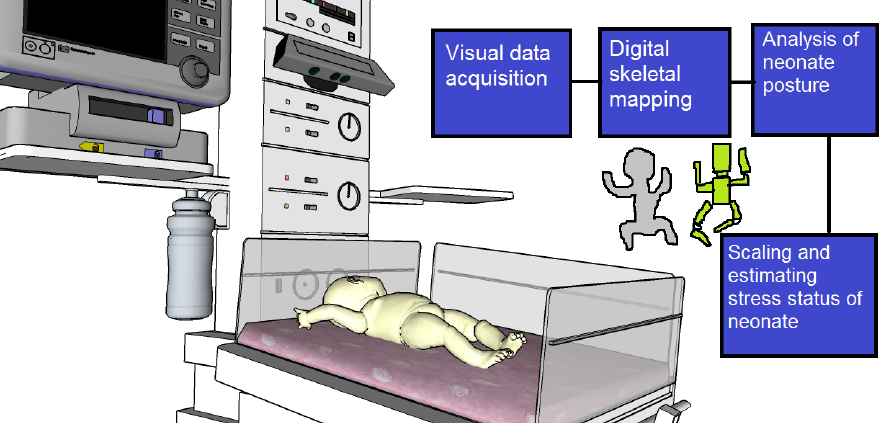
Figure 12. Microsoft Kinect experimental setup for mapping a neonate under intensive care, and estimation of behavioral patterns of the global and local body